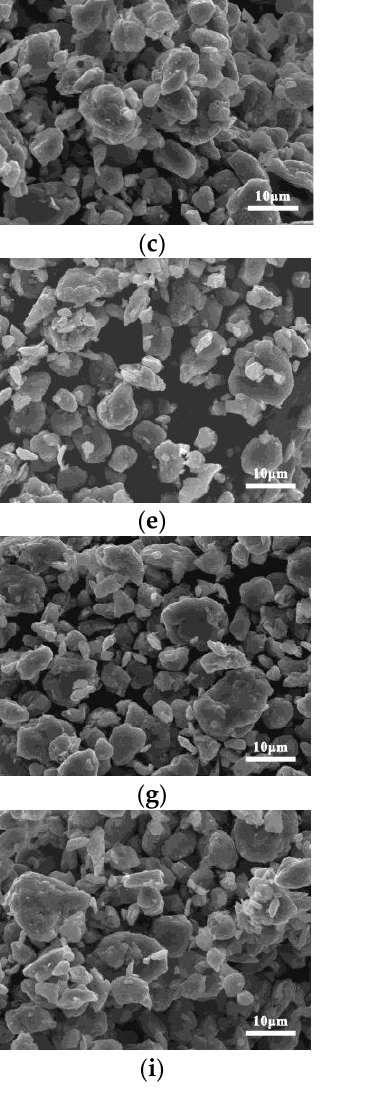
Figure 3. SEM morphology of CNT/Mg powders with different contents of CNTs: ( a , b ) 0.5 vol.%; ( c , d ) 1 vol.%; ( e , f ) 1.5 vol.%; ( g , h ) 2 vol.%; ( i , j ) 2.5 vol.% .